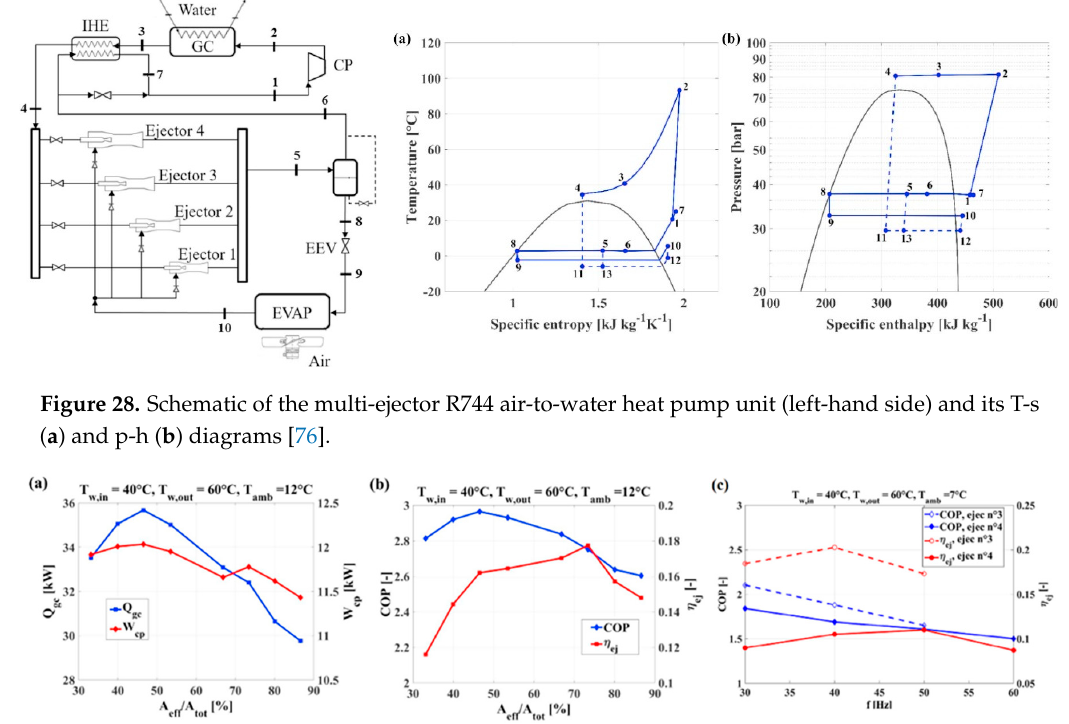
Figure 29. ( a ) Heating capacity (left) and compressor work (right) variations as a function of the overall ejector cross section; ( b ) COP (left) and ejector efficiency (right) variations as a function of the overall ejector cross section; ( c ) COP (left) and ejector efficiency (right) as a function of the compressor frequency [76].